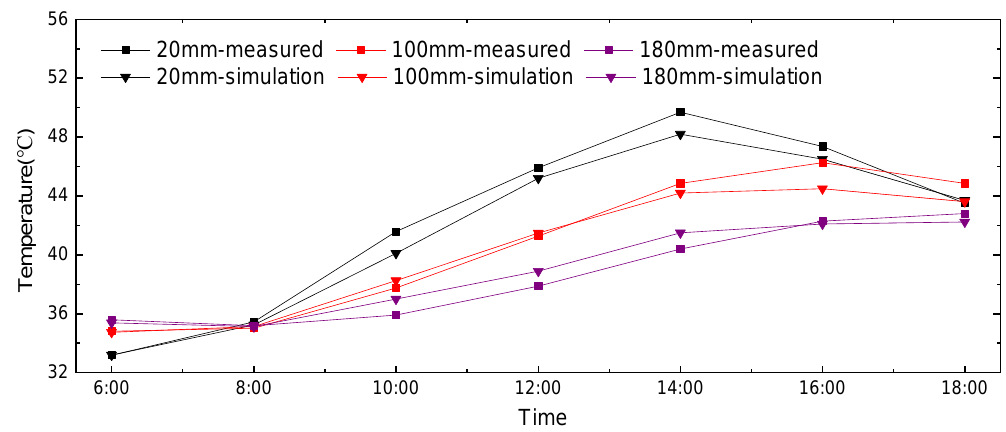
Figure 13. Comparison between the simulation and measurement results of the slab track temperature.